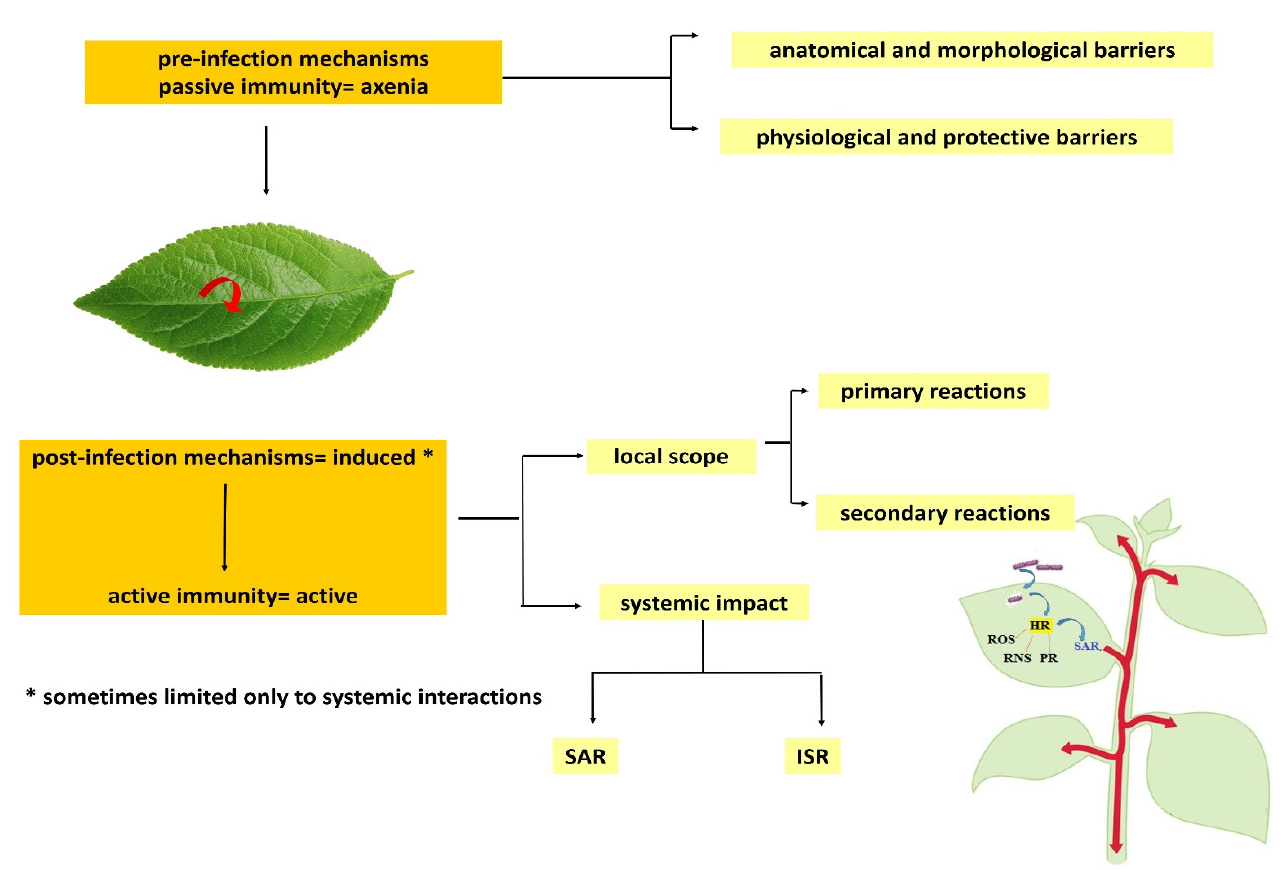
Figure 2. Induced and active immunity. Source: